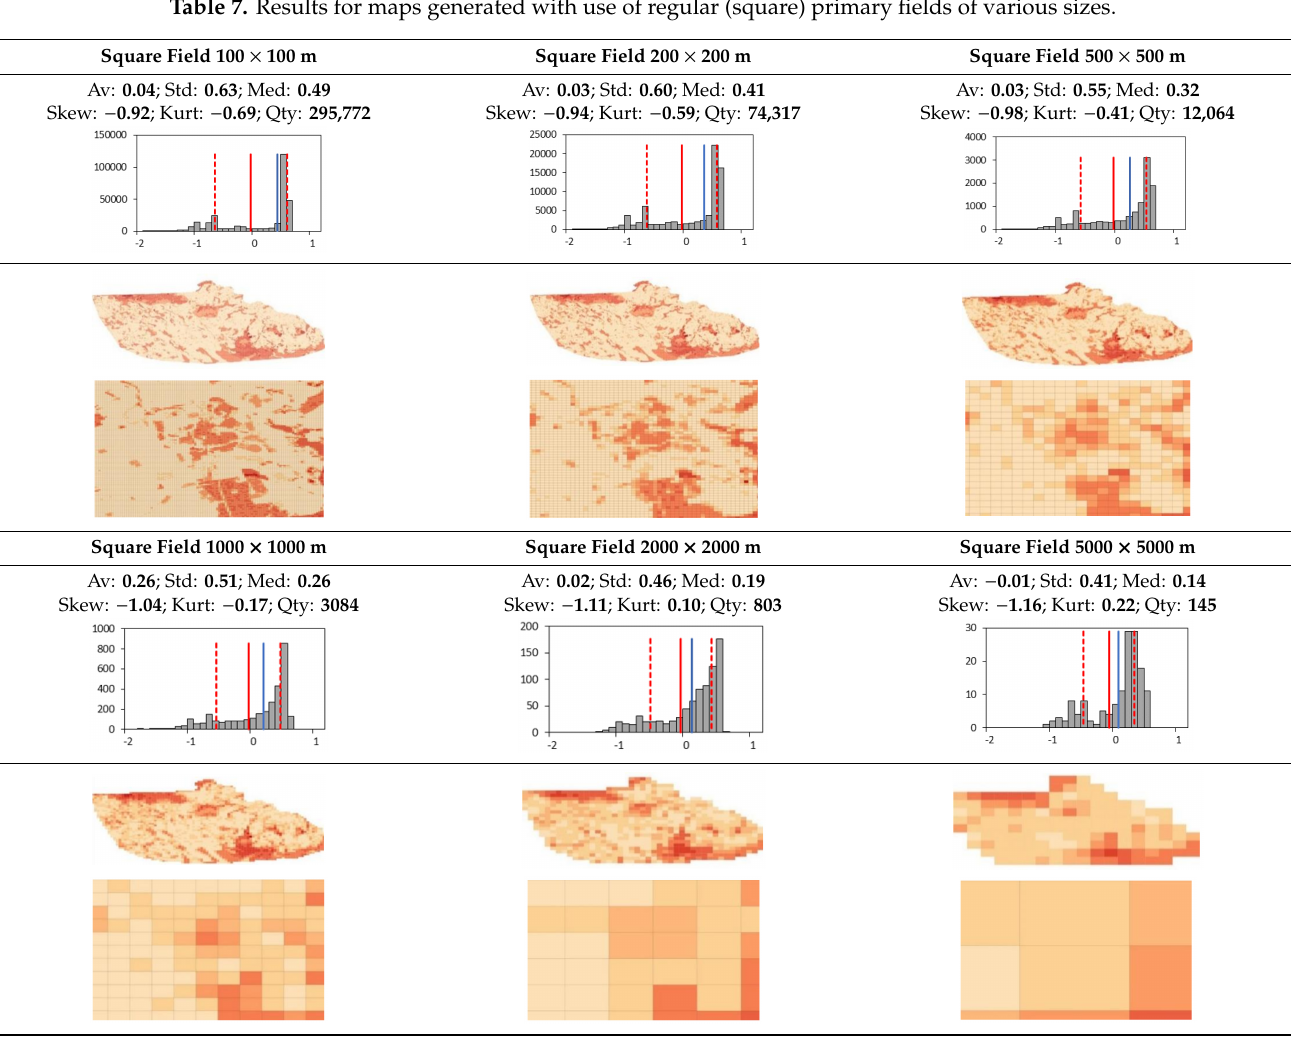
Table 7. Results for maps generated with use of regular (square) primary fields of various